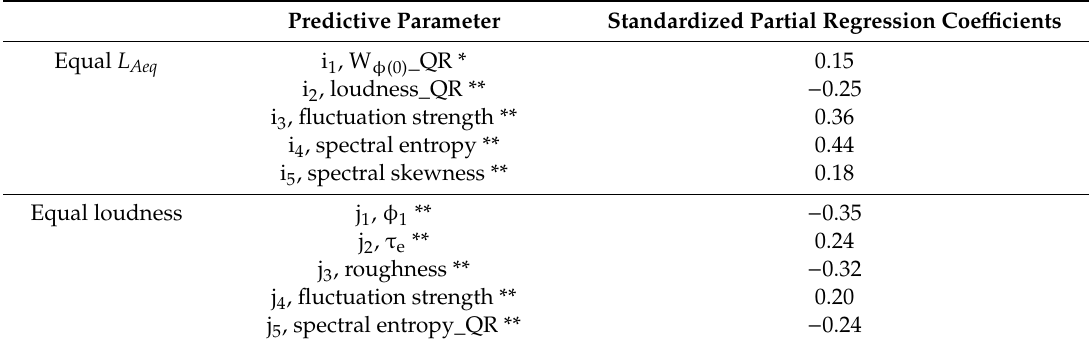
Table 6. Significant predictive parameters and standardized partial regression coe ffi cients revealed by multiple linear regression analyses of inset song